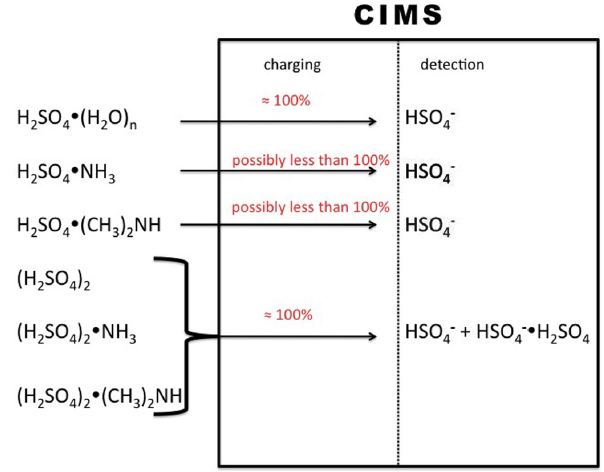
Fig. 1. Schematic of the performance of the CIMS instrument for various sulfuric acid – containing small clusters. The scheme illus- trates two fundamental issues: only part of some base-containing clusters may be charged, and the base molecules will evaporate prior to detection even if the charging is successful. The qualita- tive estimates of charging efficiencies correspond to the Helsinki University CIMS (Pet¨aj¨a et al., 2009, and references therein). See text for